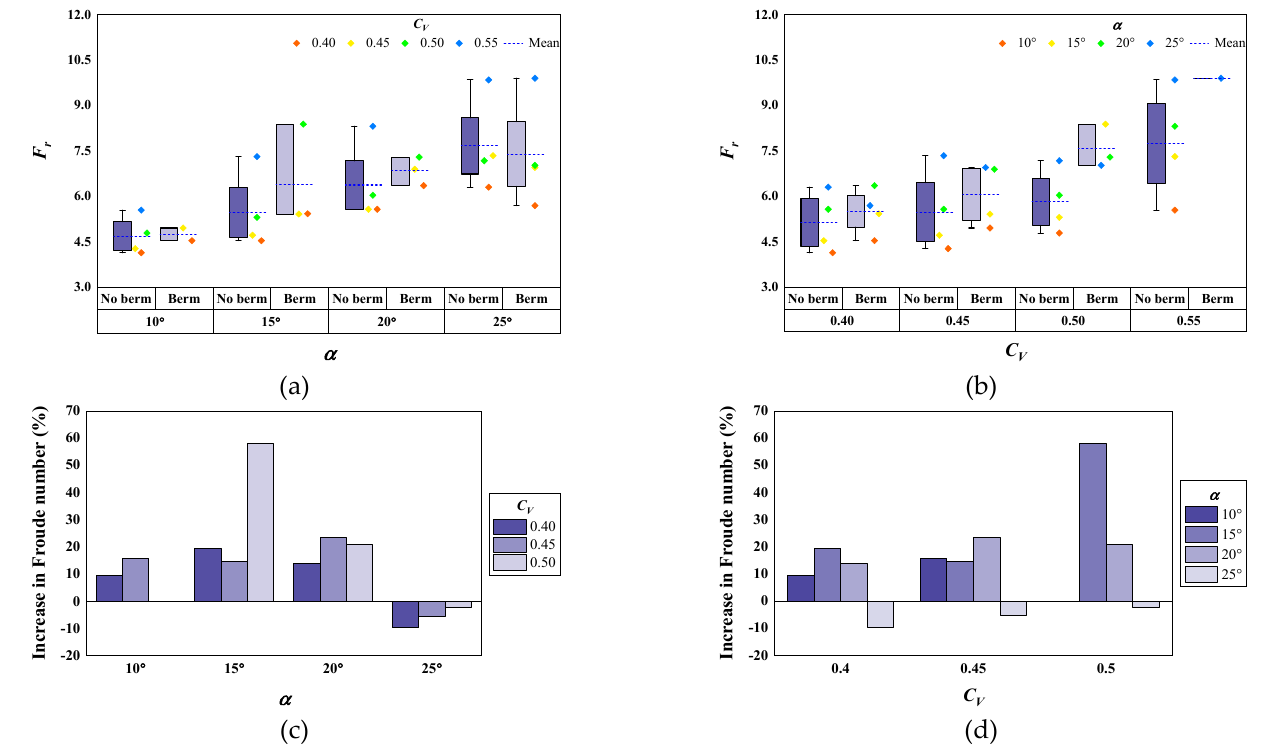
Figure 8. ( a ) Froude number according to α (at C V = 0.40–0.55); ( b ) Froude number according to C V (at α = 10°–25°); ( c ) percent increase in Froude number due to berm according to α (at C V = 0.40–0.50); ( d ) percent increase in Froude number due to berm according to C V (at α = 10°–25°).